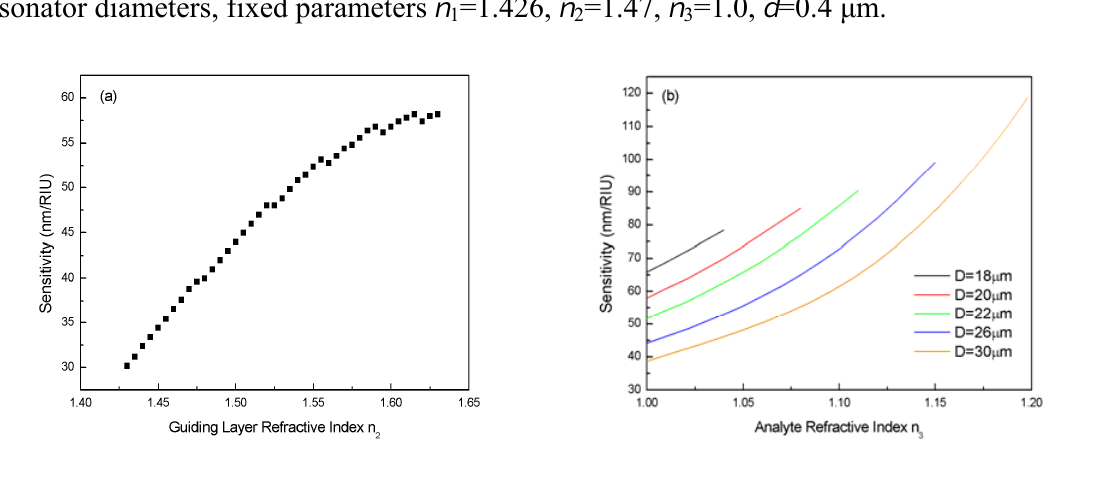
Figure 6. (a) Sensitivity versus guiding layer refractive index, fixed parameters n n =1.0, d =0.4 μ m, D =30 μ m. (b) Sensitivity versus analyte refractive index for five different 3 resonator diameters, fixed parameters n